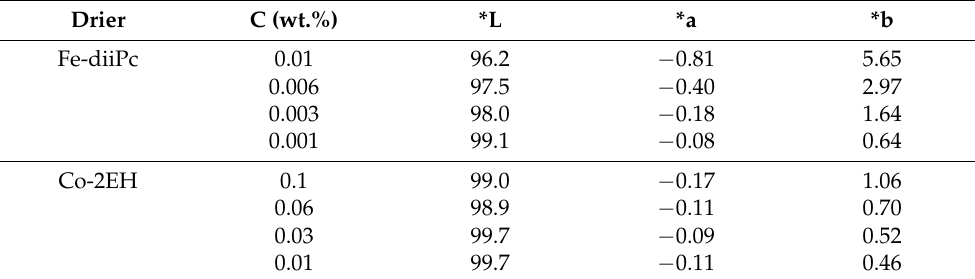
Table 6. Coloration of transparent coatings treated by Fe-diiPc and Co-2EH 1 . Drier C (wt.%) *L *a *b Fe-diiPc 0.01 96.2 − 0.81 5.65 0.006 97.5 − 0.40 2.97 0.003 98.0 − 0.18 1.64 0.001 99.1 − 0.08 0.64 Co-2EH 0.1 99.0 − 0.17 0.06 98.9 − 0.11 0.03 99.7 − 0.09 0.01 99.7 − 0.11